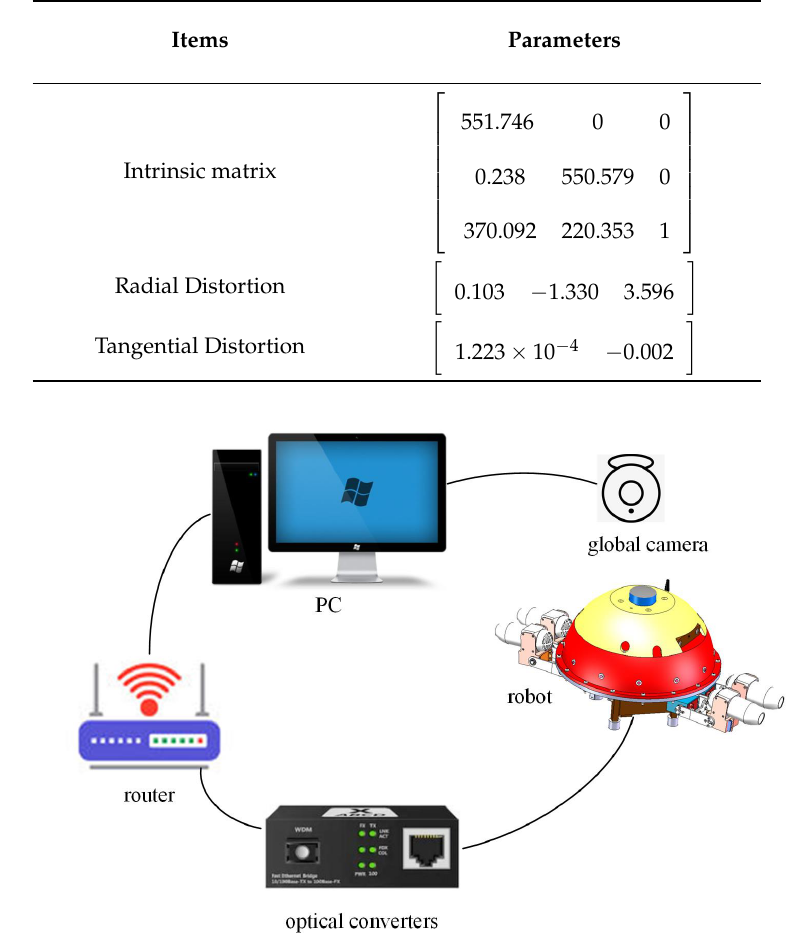
Table 2. The Parameters of the global camera.